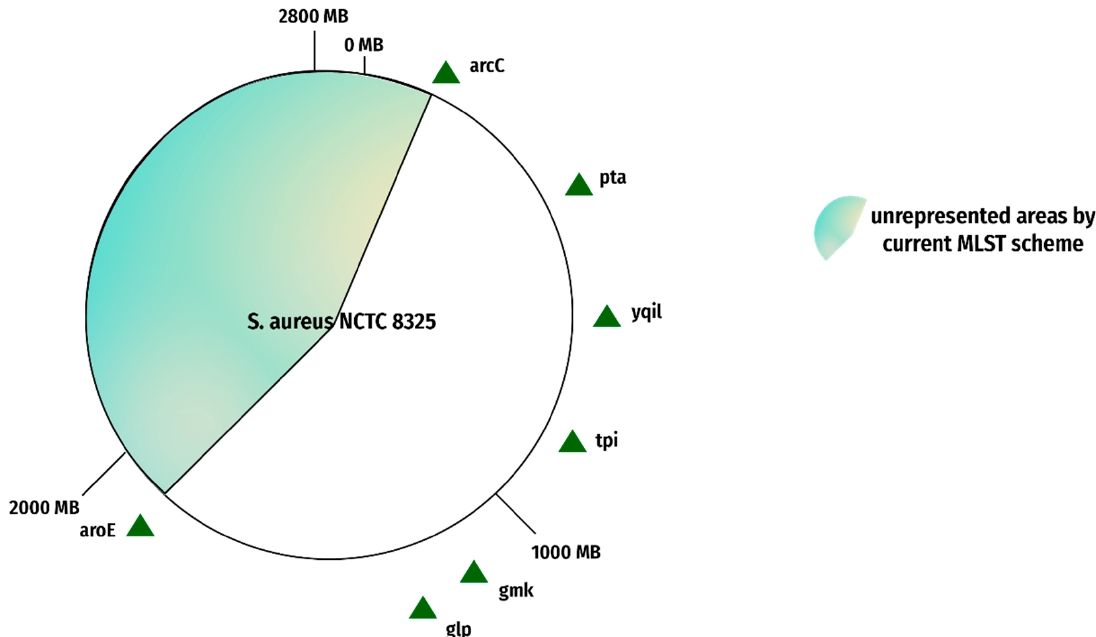
Figure 5. Current MLST gene loci. The figure represents the gene loci of the current MLST scheme on reference genome NCTC 8325. The red portion indicates an unrepresented area, and the green triangles show current MLST gene loci.